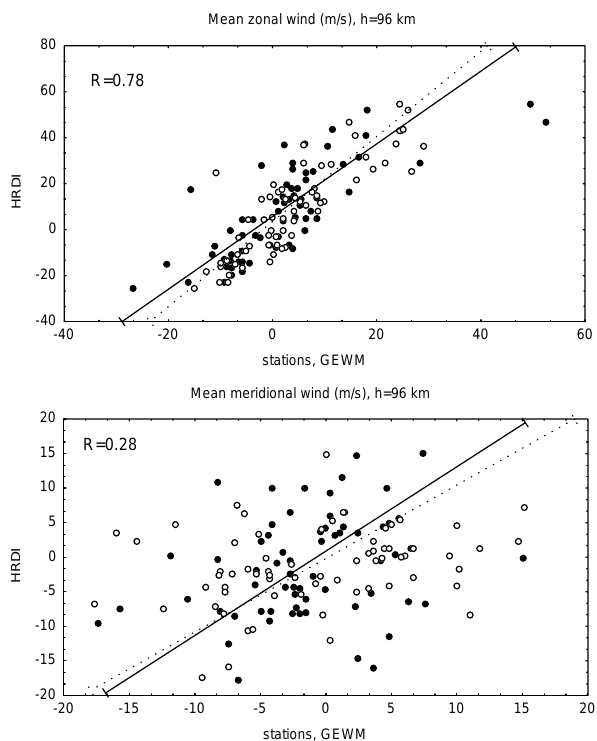
Fig. 1. Scatter plots of HRDI monthly mean zonal winds at latitudes 52 ◦ N, 35 ◦ N, 22 ◦ N, 2 ◦ N, 6 ◦ S, and 35 ◦ S, representing averages of measurements made during the 1991–1999 period, versus the corresponding ground-based measurements at the same latitudes. Filled circles: HRDI winds versus winds measured at the individual MF and meteor radar stations (Obninsk, 52 ◦ N; Shigaraki, 35 ◦ N; Hawaii, 22 ◦ N (1991–1992); Christmas I., 2 ◦ N; Jakarta, 6 ◦ S; Ade- laide, 35 ◦ S); the solid line is the corresponding least-squares fit. Open circles: HRDI winds versus the corresponding GEWM winds at the same latitudes; least-squares fit to these data is the broken line. Top: zonal winds. Bottom: meridional winds. All data are at a height of